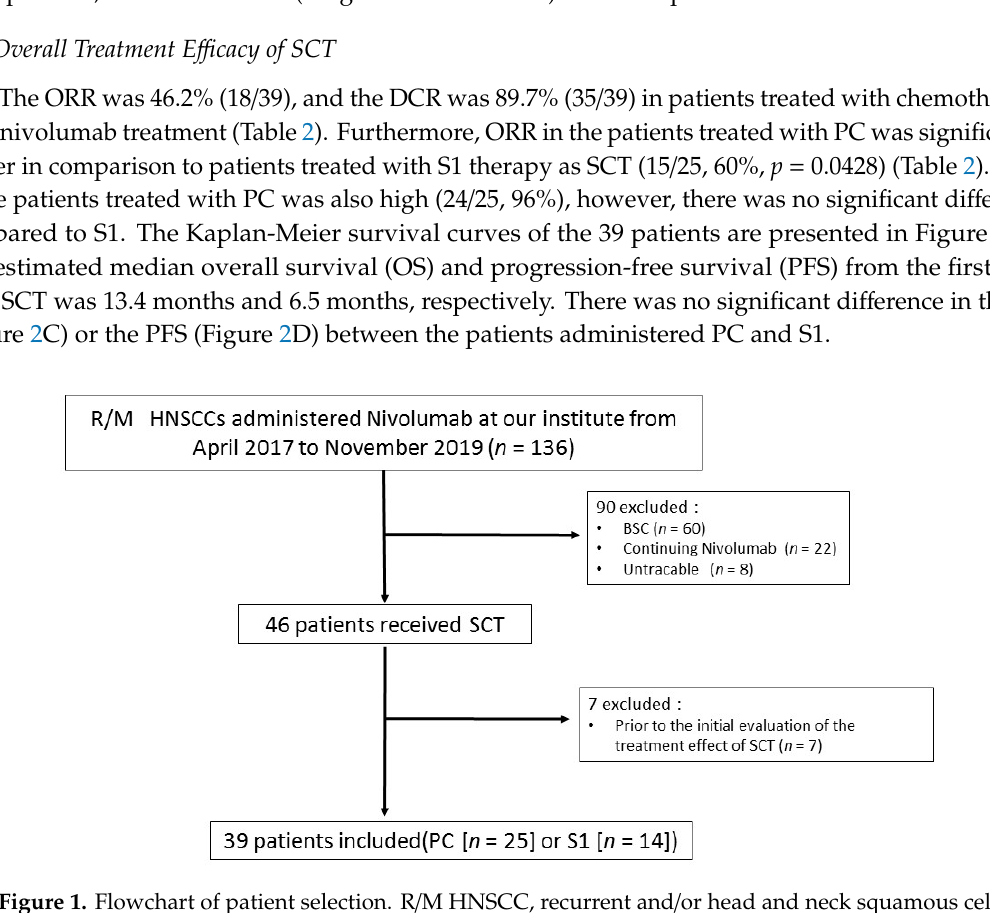
Figure 1. Flowchart of patient selection. R/M HNSCC, recurrent and/or head and neck squamous cell carcinoma. BSC, best supportive care; SCT, salvage chemotherapy; PC, combination chemotherapy of weekly paclitaxel and cetuximab; S1, tegafur-gimestat-otastat potassium. Table 1. Patient and tumor characteristics.